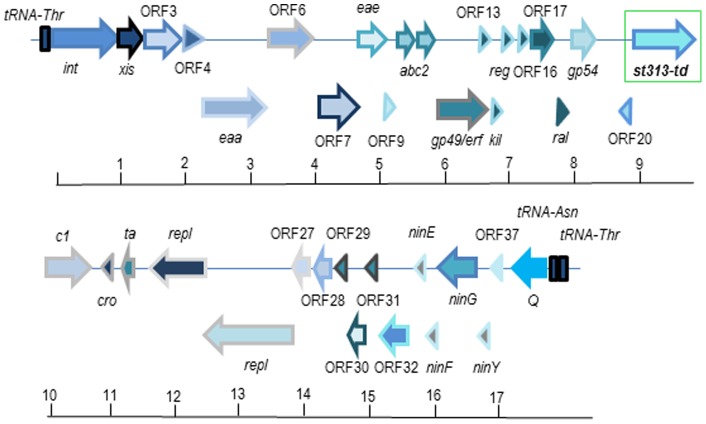
Genetic structure of ST313-GI.The genomic organization is shown with a scale in kb. Arrow above the scale represents predicted ORFs and their transcription directions. ORF 21 corresponds to the virulence gene st313-td and is highlighted with a rectangle. Twenty-one ORFs encode phage-related functions: integration and excision: int and xis, respectively, Ea region: eaa and eae, recombination: abc2 (Anti-RecBCD), erf and kil, regulatory functions: reg, structural: gp54, anti-restriction: ral, inmunity: c1 (repressor) and cro (antirepressor), transcription: ta (transcriptional activator), replication: repl, Nin region: nin, antitermination: Q (Q protein). The sequence data have been extracted from the sequenced genome of the strain S. Typhimurium D23580, accession no. FN424405.1. The location of ST313-GI within this genome is 368767_386754. The location of st313-td is; 377825_378748 (locus_tag = ”STMMW_03531” and protein id: “YP_005231421.1”). All the genes within ST313-GI have been annotated in the genome of D23580. The function of the encoded proteins was determined by using the Uniprot database (http://www.uniprot.org/). See additional Table S2 for more details.